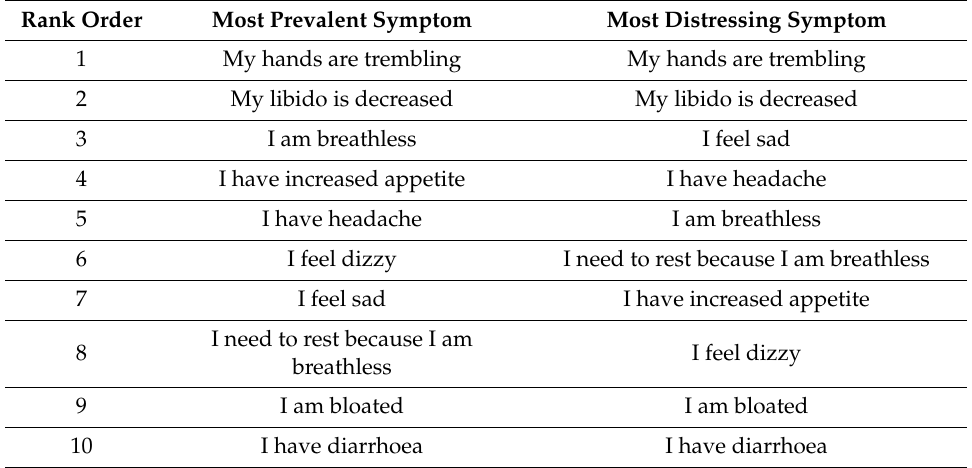
Table 4. The ten most frequent and distressing symptoms among 79 heart recipients one to five years after heart transplantation.